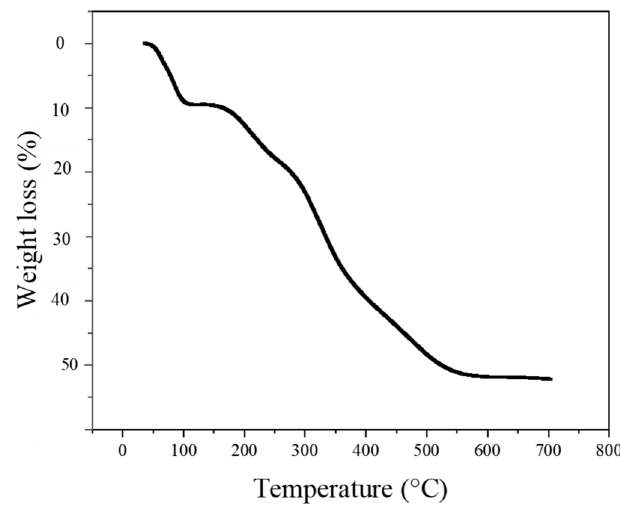
Figure 6. TGA curve of Au-decorated ZnO-PANI (25 wt.%) composite nanofibers.